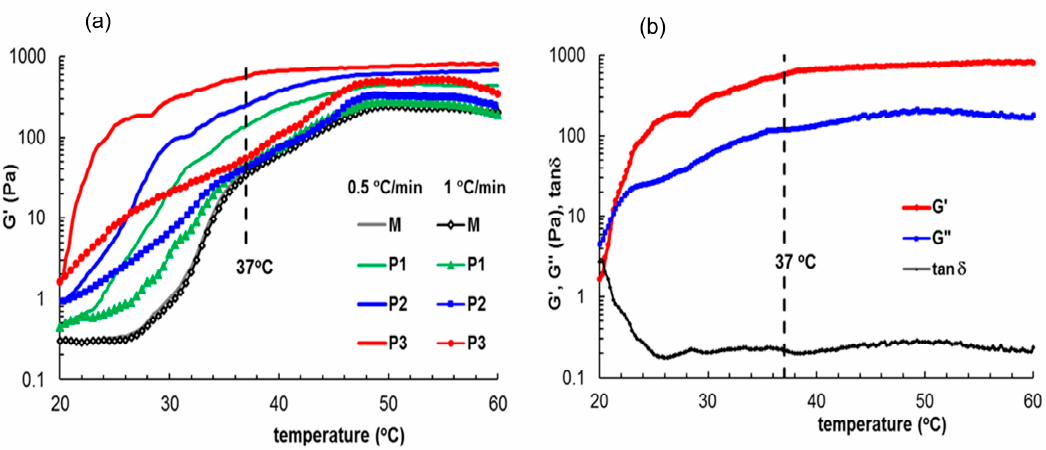
Figure 6. G’ variation during gelation induced by temperature increase at different heating rates ( a ) 1 °C/min (full symbols) and 0.5 °C/min (lines); ( b ) viscoelastic parameters for sample P3 as a function of temperature for a heating rate of 0.5 °C/min. Table 2. Gelation temperature and some rheological characteristics of gel samples at 37 ◦